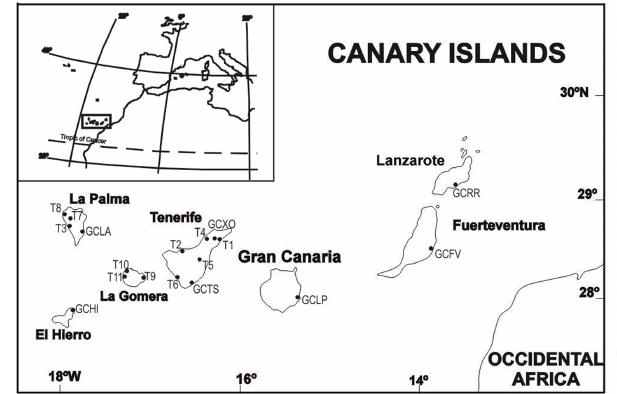
Fig. 1. Geographic location of the Canary Islands and recording stations used in the study. The airport is the only station included for Gran Canaria in this figure, the others are shown in Fig.